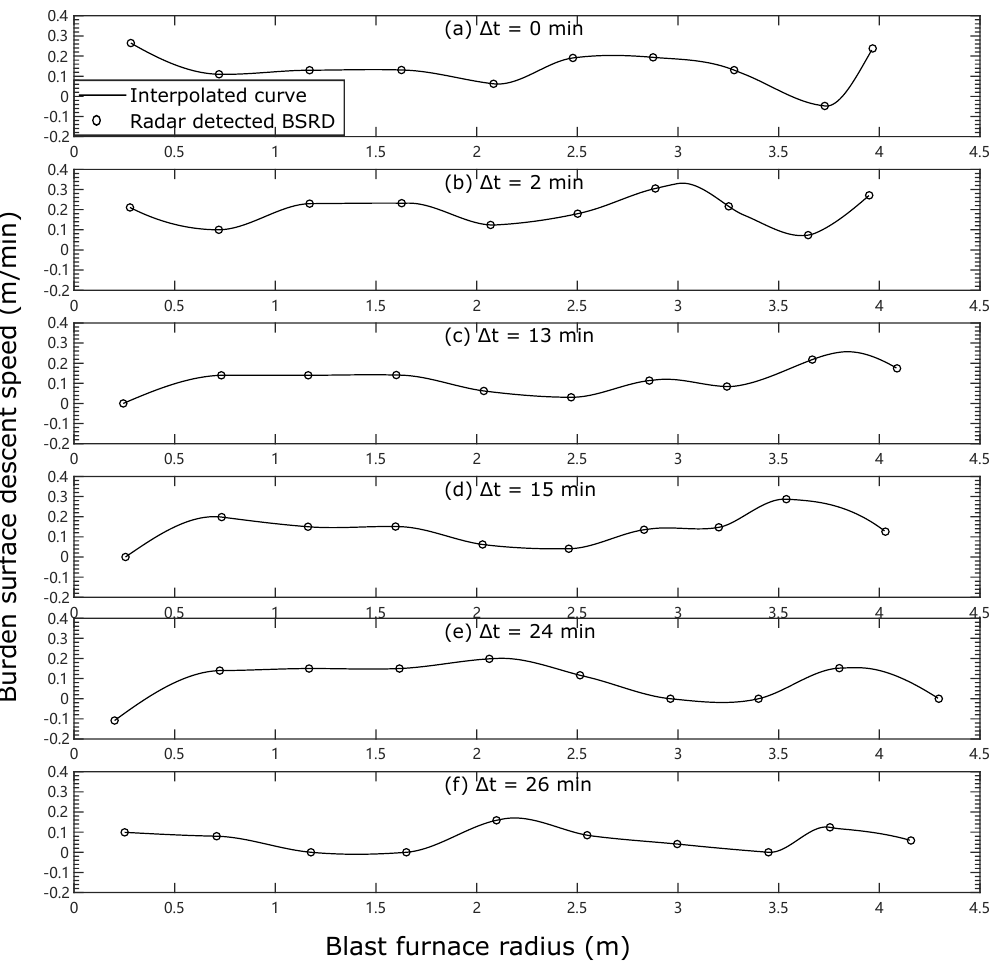
Figure 3. The variation in BSRDs within half an hour: ( a – f ) detection results obtained at different